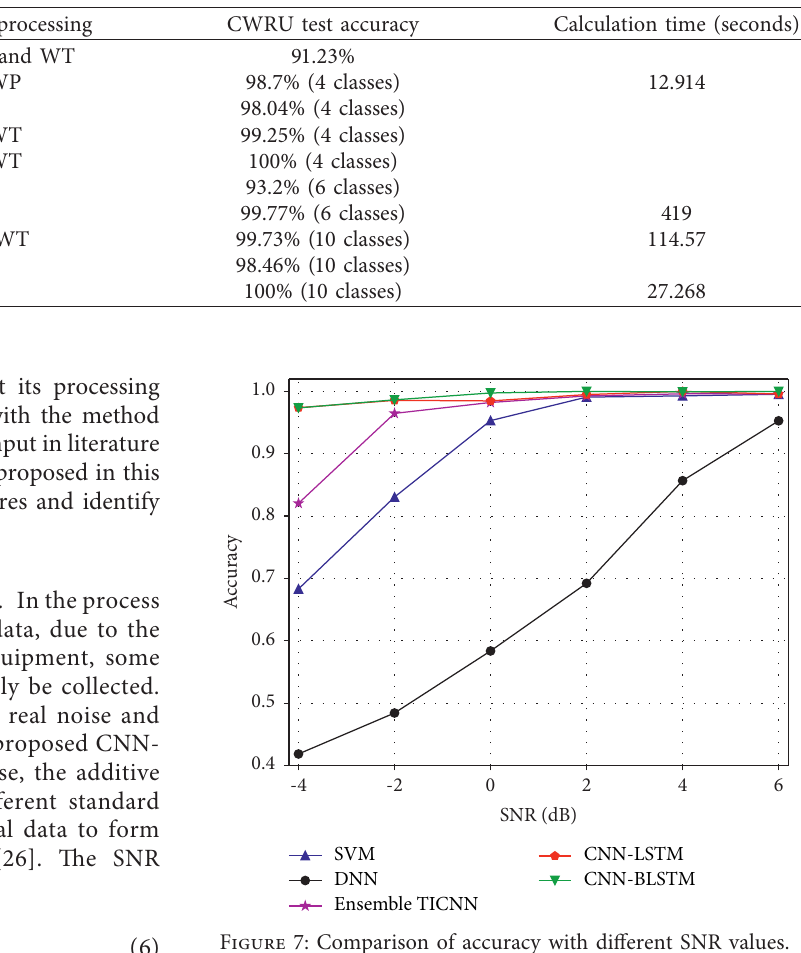
Table 5: Comparison between other methods in the literature and our proposed model.